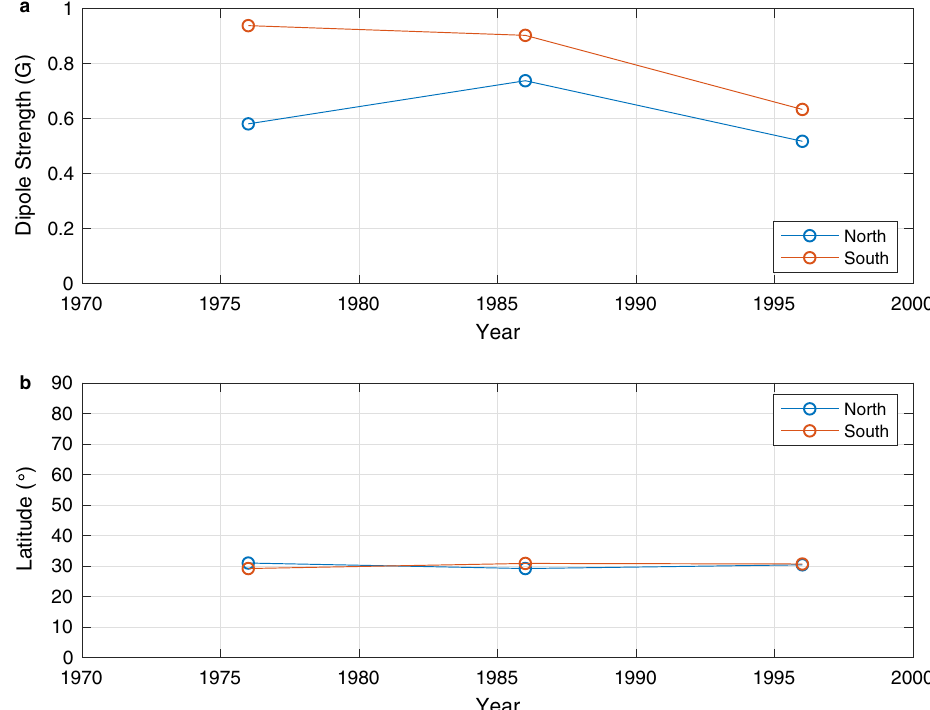
Fig. 4. Parameters of the northern and southern dipoles. (a) Strengths of the northern and southern dipole for the three solar minima (1975 – 1976, 1985 – 1986 and 1995 – 1996). The southern dipole is stronger than the northern dipole during all three solar minima. (b) Locations of the northern and southern dipoles in solar latitude (southern latitudes are reversed to